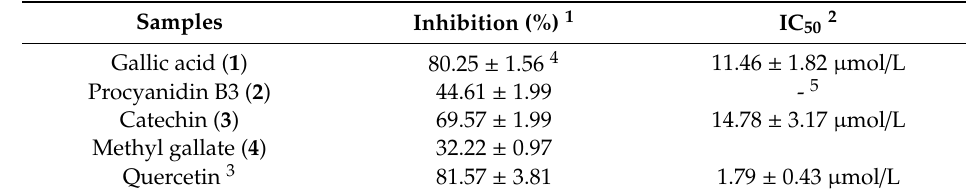
Table 3. The rat lens aldose reductase (RLAR) inhibitory activities of isolated compounds from